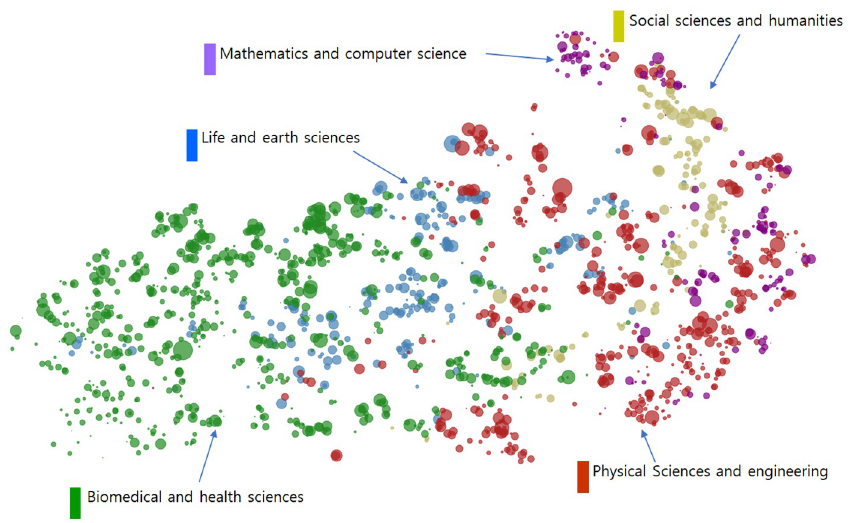
Fig 7. Abstract-based mapping of all technology